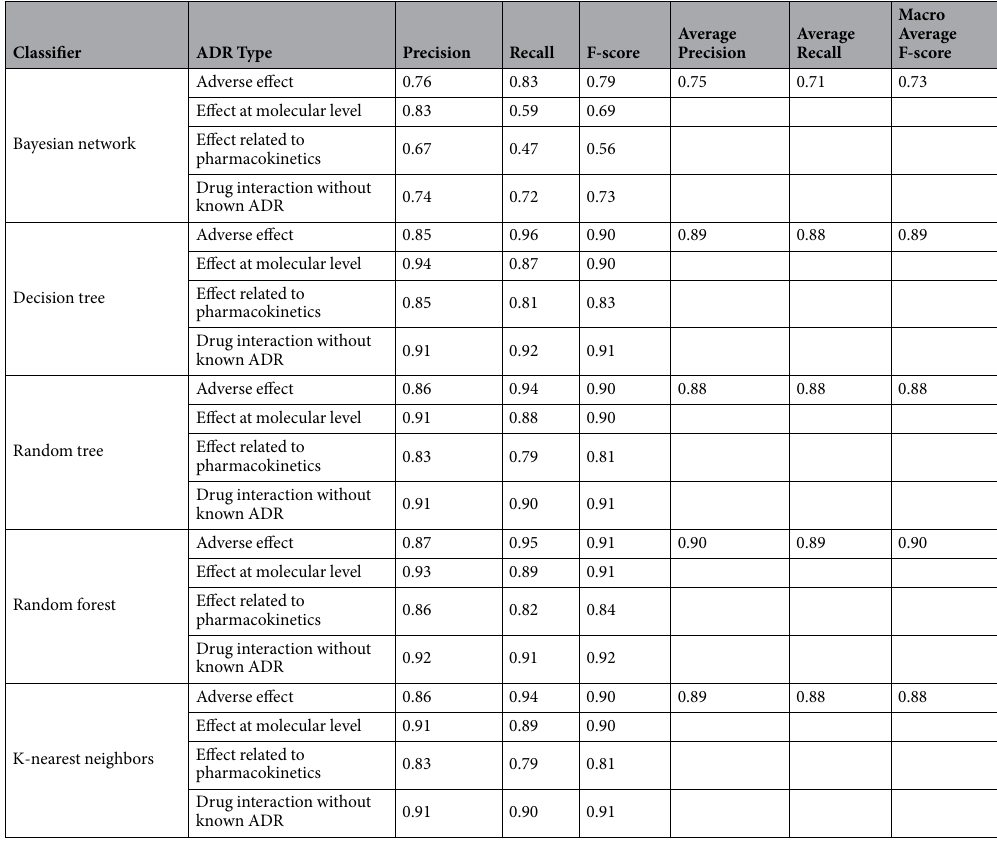
Table 4. Performance of classification on ADR types using DDI and DGI features on DDI corpus training